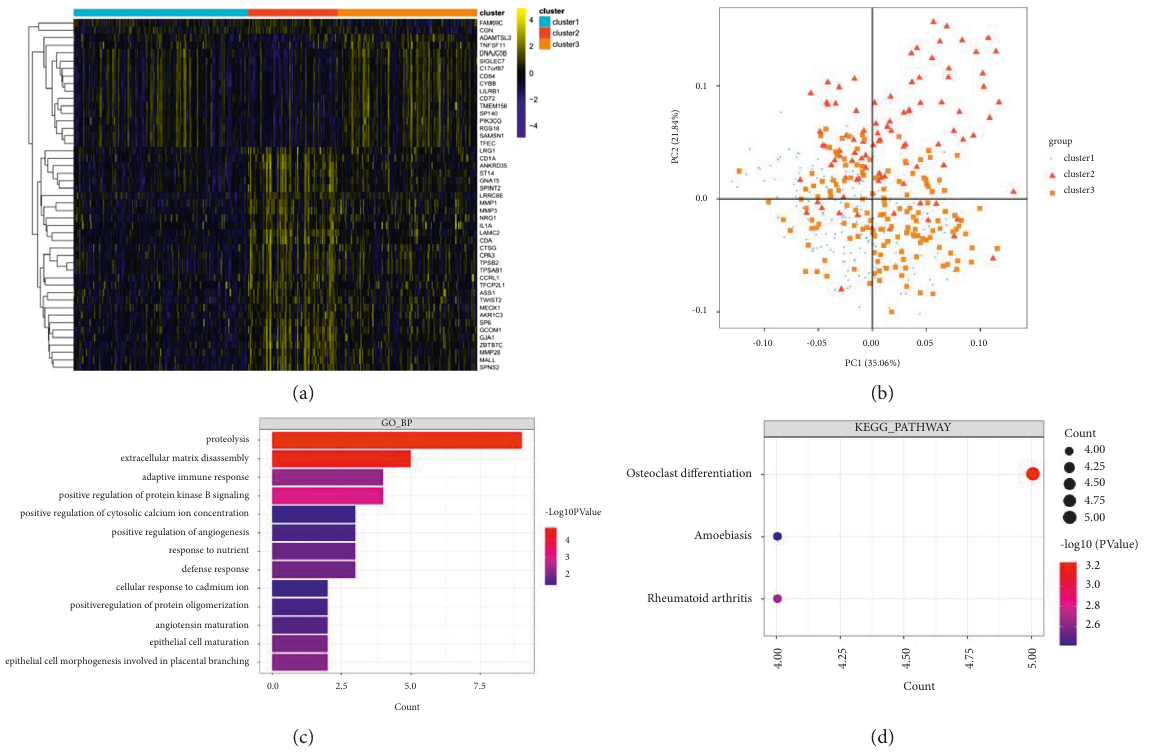
Figure 6: Identification of differentially expressed genes (DEGs) between subtypes. (a) The heatmap of 47 common DEGs. (b) The principal component analysis (PCA) of 47 common DEGs. (c) The gene ontology (GO) enrichment analysis. Length of bar chart represents the number of genes enriched in each term. The color of the ball represents the P value. (d) The Kyoto Encyclopedia of Genes and Genomes (KEGG) pathway enrichment analysis. The size of the ball represents the number of genes enriched in each term. The color of the ball represents the P value.